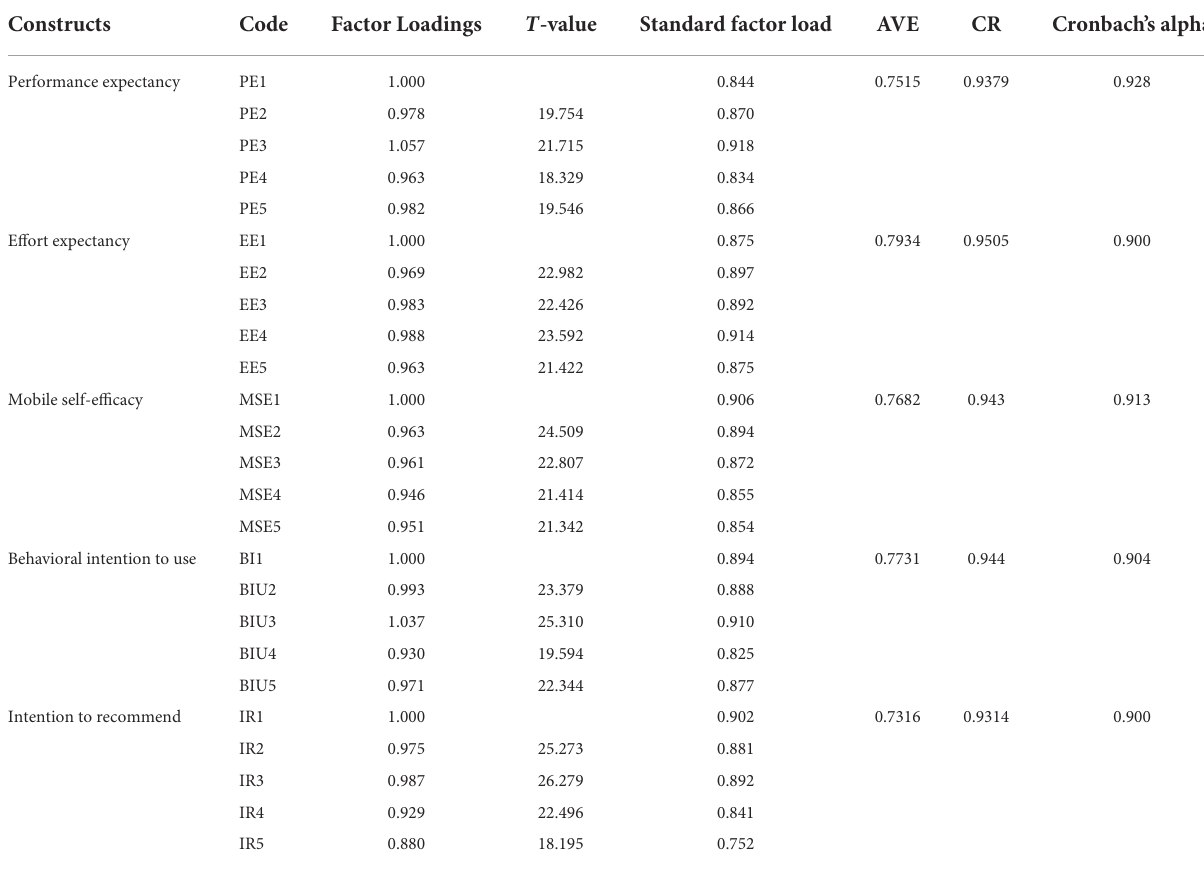
TABLE 4 Construct validity and reliability